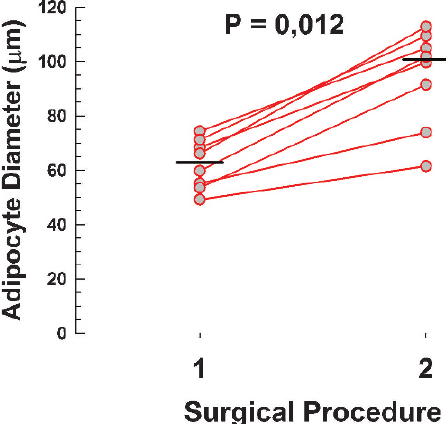
Figure 5 - Scoter plot with lines showing the variation of the number of vessels between surgical procedure 1 and 2. Short thick lines represent the series median